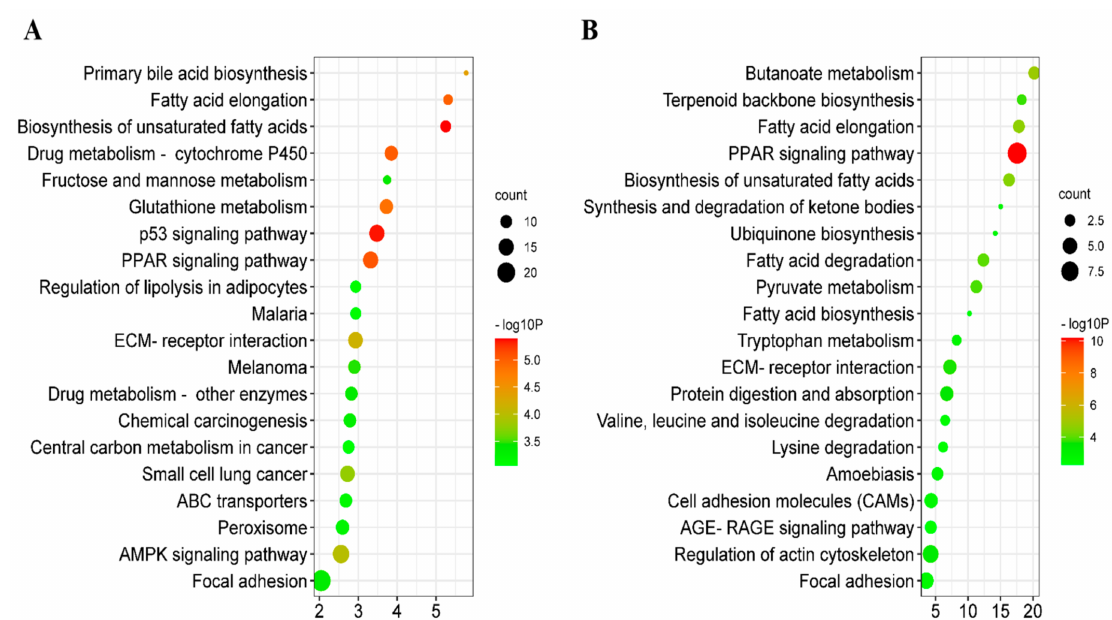
Figure 1. ( A ) The bubble diagram of the top 20 Kyoto Encyclopedia of Genes and Genomes (KEGG) enrichment pathways of differentially expressed genes (DEGs). The horizontal axis represents the enrichment score; ( B ) The bubble diagram of the top 20 KEGG enrichment pathways of differentially expressed proteins (DEPs). Table 4. The differentially expressed genes (DEGs) and differentially expressed proteins (DEPs) in the crucial Kyoto Encyclopedia of Genes and Genomes (KEGG) pathways related to fat metabolism in the adipose tissue of FYs and MYs. KEGG Pathway DEGs DEPs Biosynthesis of unsaturated fatty acids